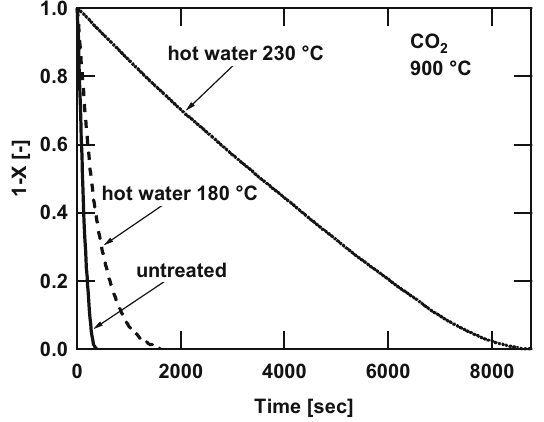
Figure 2: CO 2 gasi fi cation pro fi les at 900°C for the untreated and treated co ff ee grounds ’ chars.